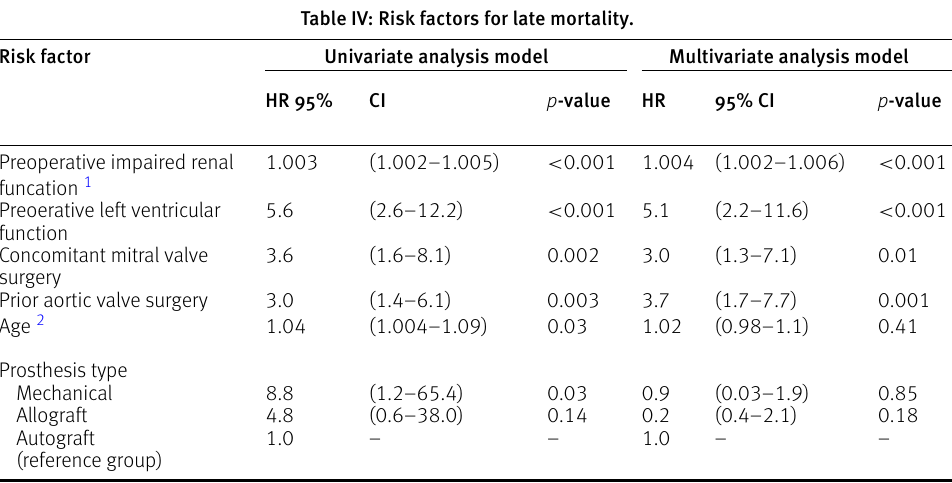
Table 2. Risk factors for late mortality. Reproduced with permission from Ref. [13]. Table IV: Risk factors for late